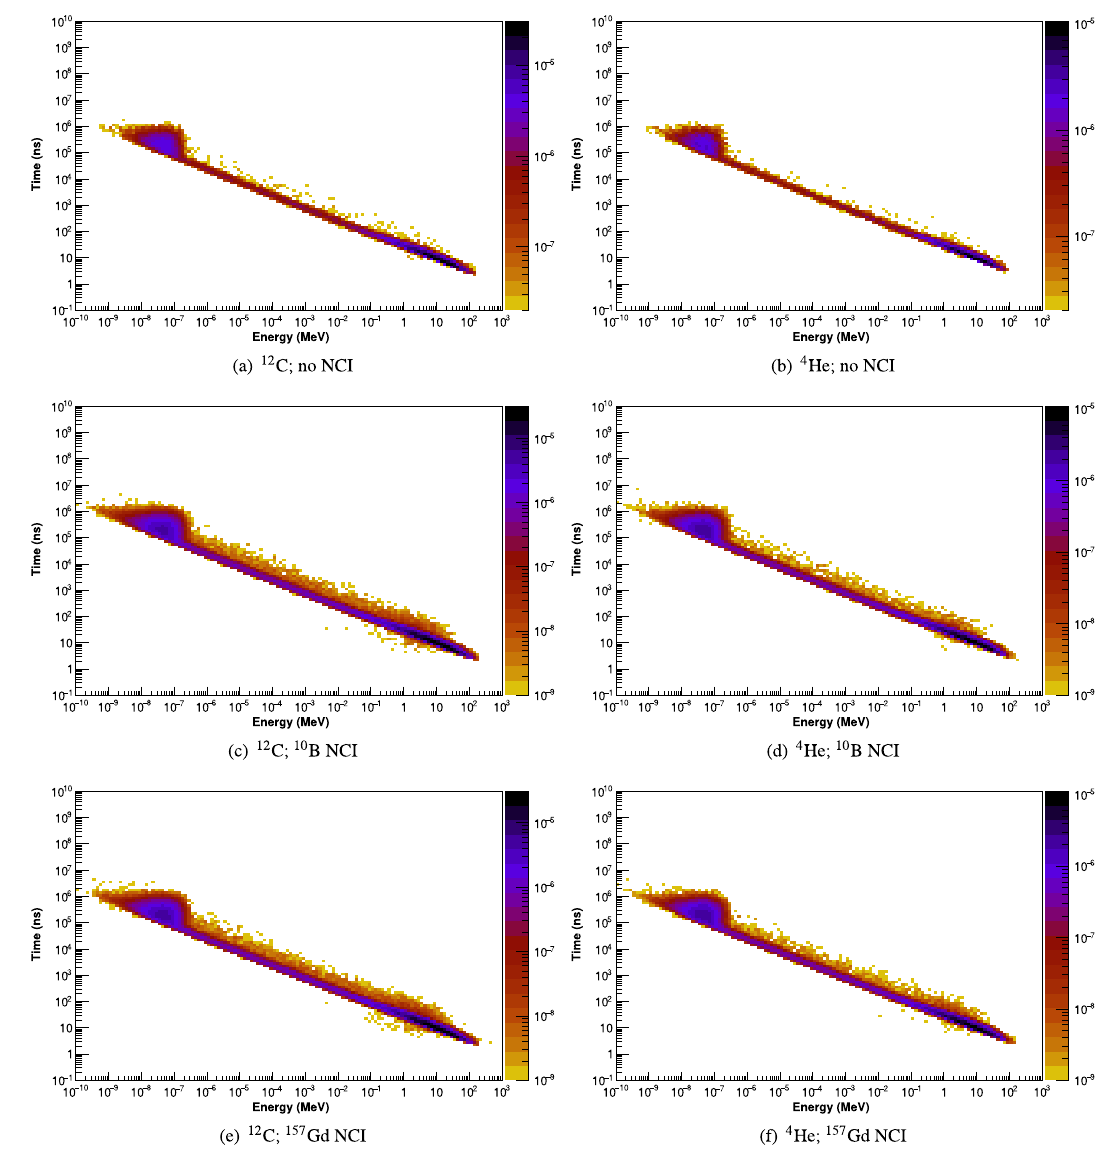
Figure 6. The energy/arrival-time spectrograms of neutrons entering the detector following irradiation by polyenergetic carbon and helium ion Detector materials. Figure 7 shows a comparison of the sensitivity and R TF of detectors with a fixed geometry and different detector materials irradiated by a carbon ion beam for fixed irradiation durations of 1 µs for the 10 B NCI and 1 ms for the 157 Gd NCI (a comparison of irradiation durations is discussed in the next subsection). For the 10 B NCI, both the highest true positive rate and lowest false positive rate were obtained with the CdTe detector, resulting in the highest R TF ( R TF = 2.07 ± 0.01 ) of all evaluated materials. The next-best performing